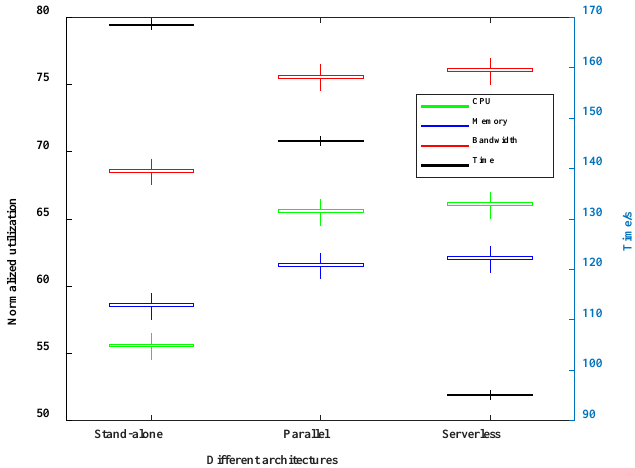
Figure 11. Computing performance under different architectures.